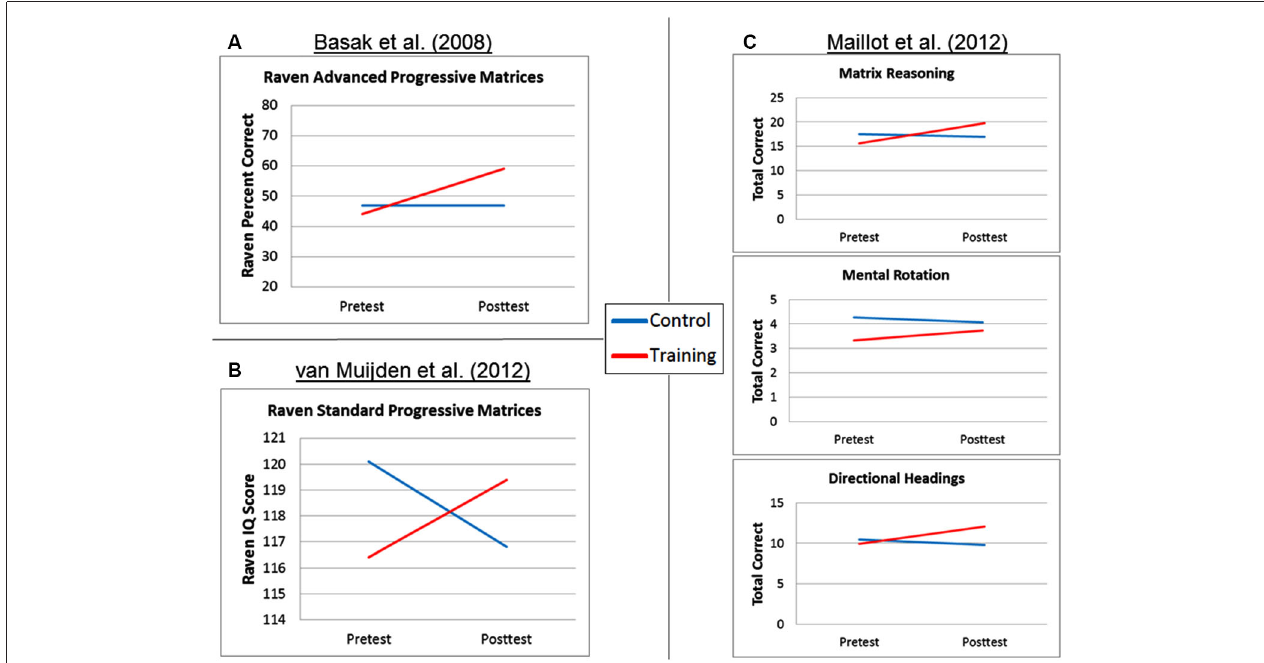
FIGURE 1 | Spatial ability transfer results as a function of group for (A) Basak et al. (2008), (B) van Muijden et al. (2012), and (C) Maillot et al. (2012)